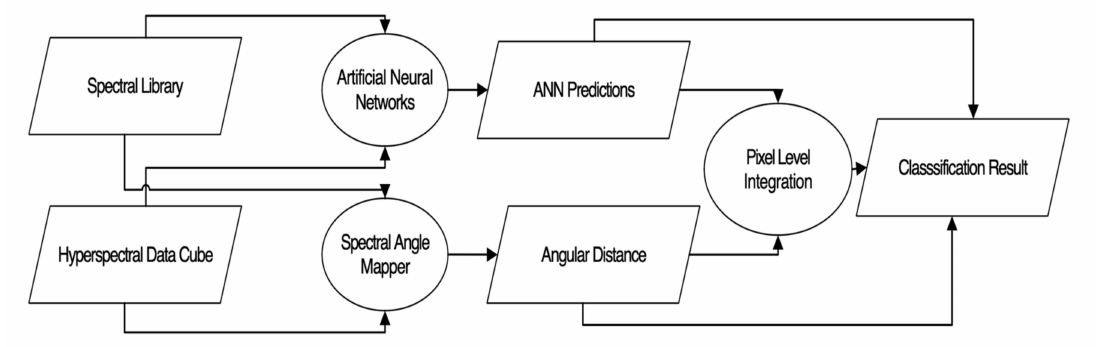
Figure 7. Flowchart of the proposed algorithm.